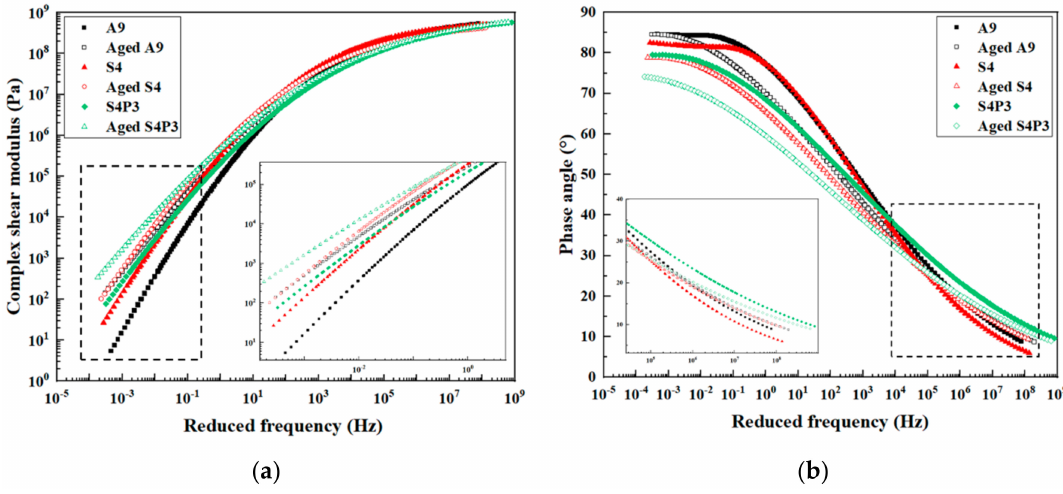
Figure 1. Master curves of asphalt binders before and after aging. ( a ) Complex shear modulus; ( b ) phase